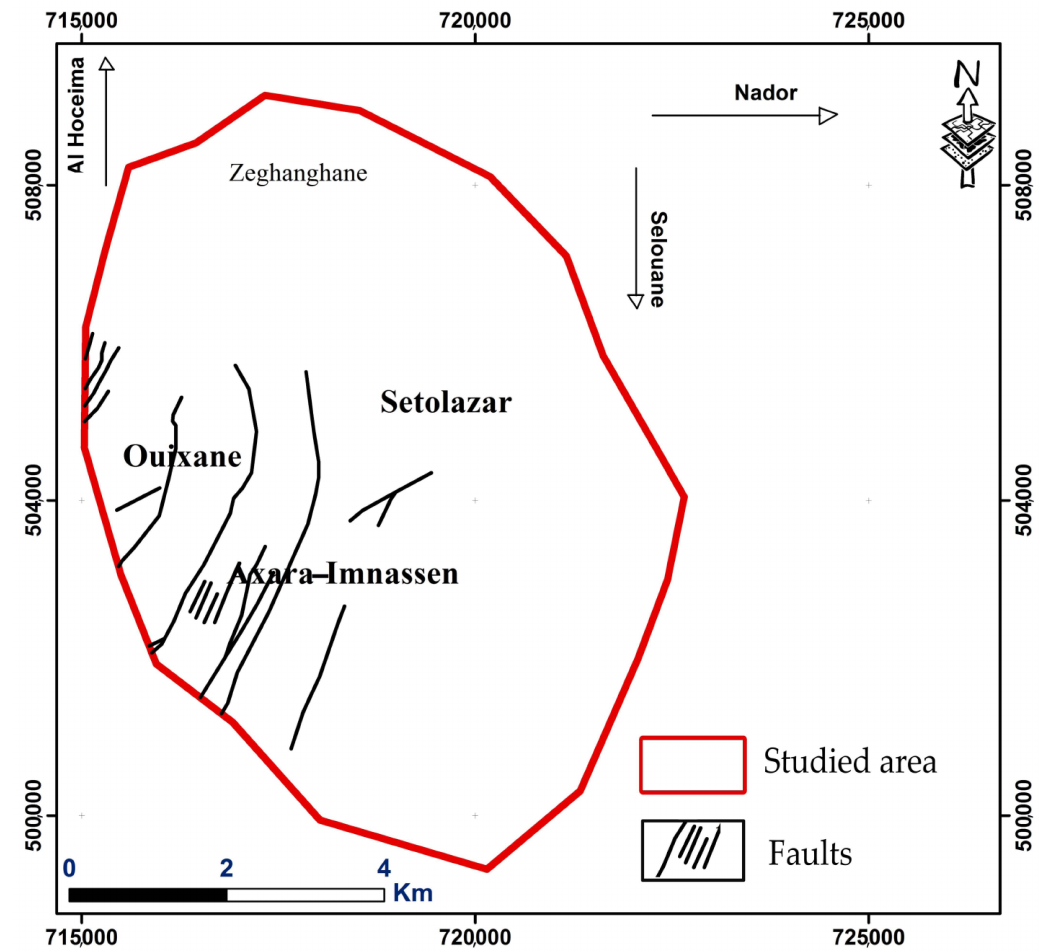
Figure 11. Percentage of the different vulnerability classes in the studied area.